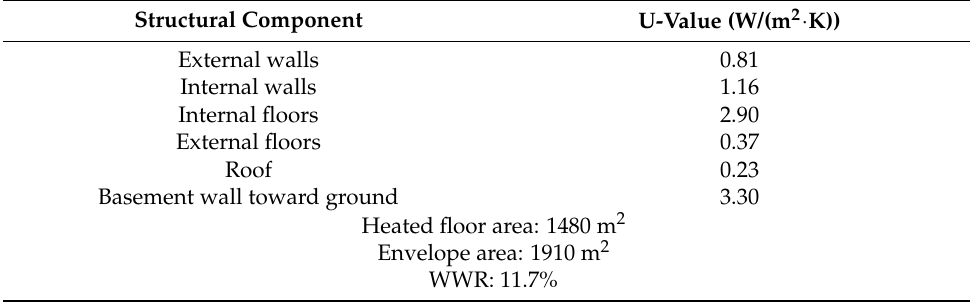
Table 3. Detailed properties of window.